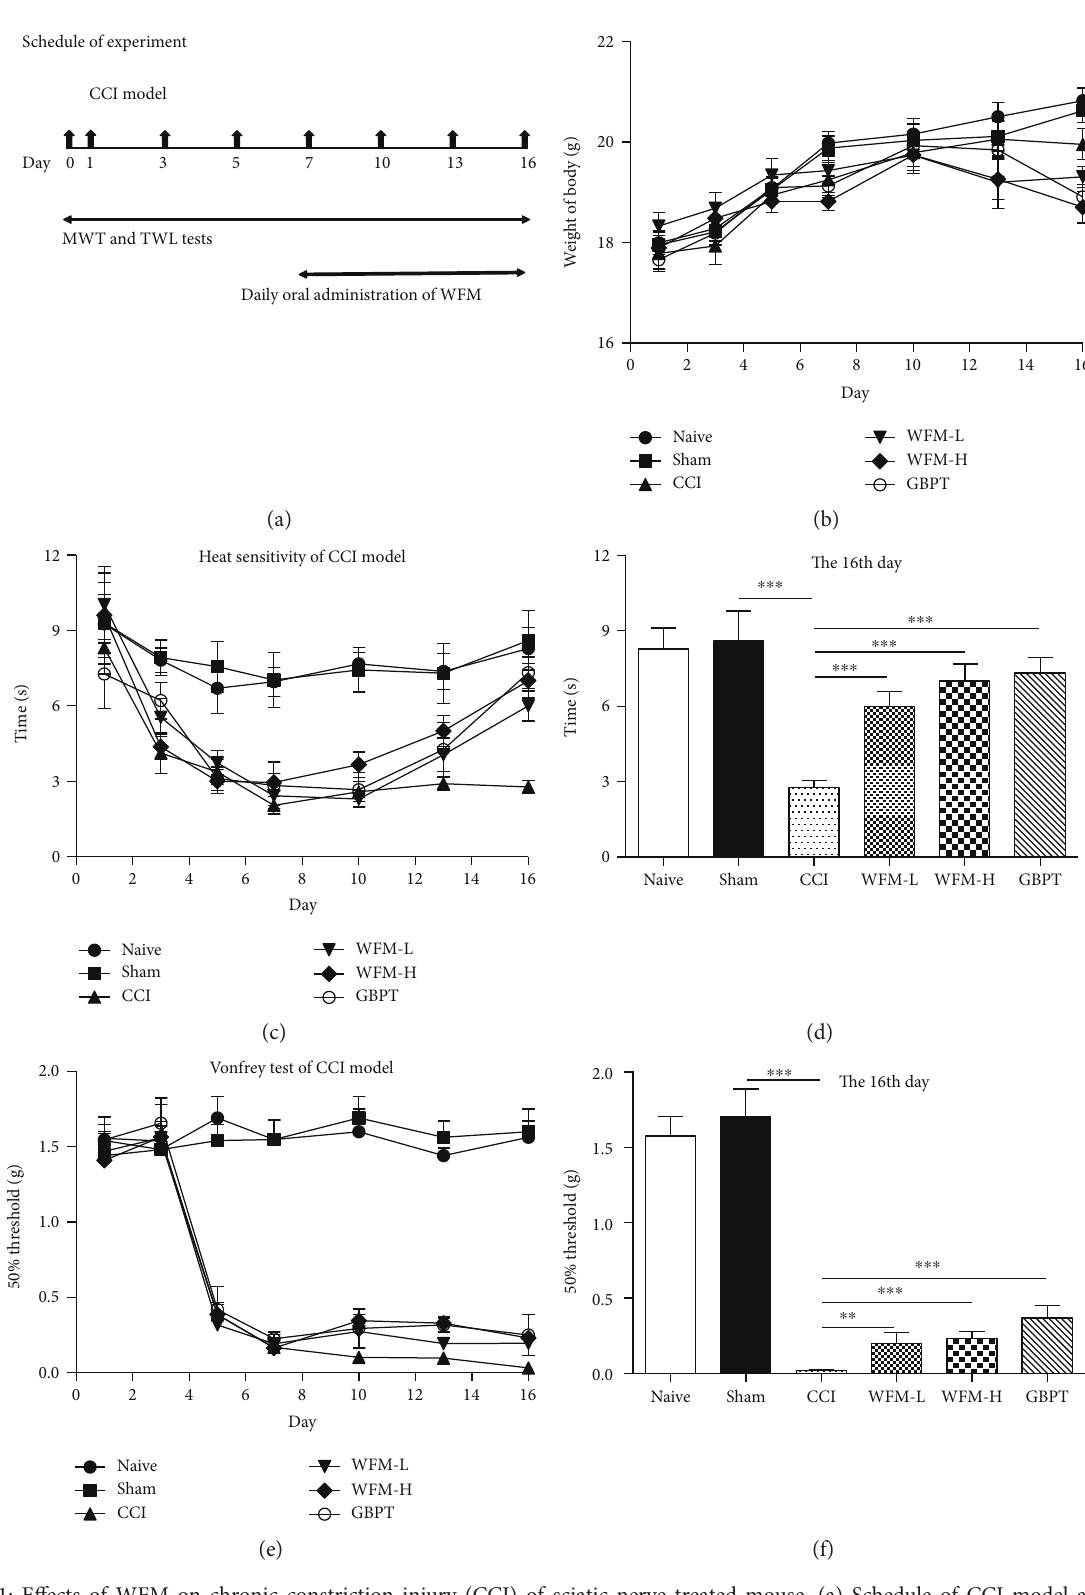
Figure 1: E ff ects of WFM on chronic constriction injury (CCI) of sciatic nerve treated mouse. (a) Schedule of CCI model and WFM treatment. (b) There was no di ff erence in the body weight after vehicle or drug treatment among six groups. (c, d) E ff ects of WFM in the thermal withdrawal latency (TWL) was recorded ( n = 12 ). (e, f) E ff ects of WFM in the mechanical withdrawal threshold (MWT) was recorded ( n = 12 ). ∗ p < 0 05 , ∗∗ p < 0 01 , ∗∗∗ p < 0 001